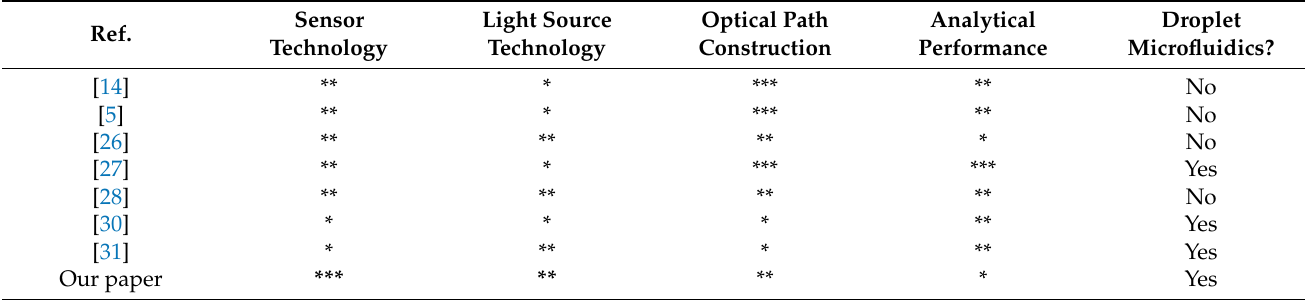
Table 1. Comparison of reviews on detection techniques in microflow cytometry. The level of detail of the various aspects discussed is rated from low to high (*–***).